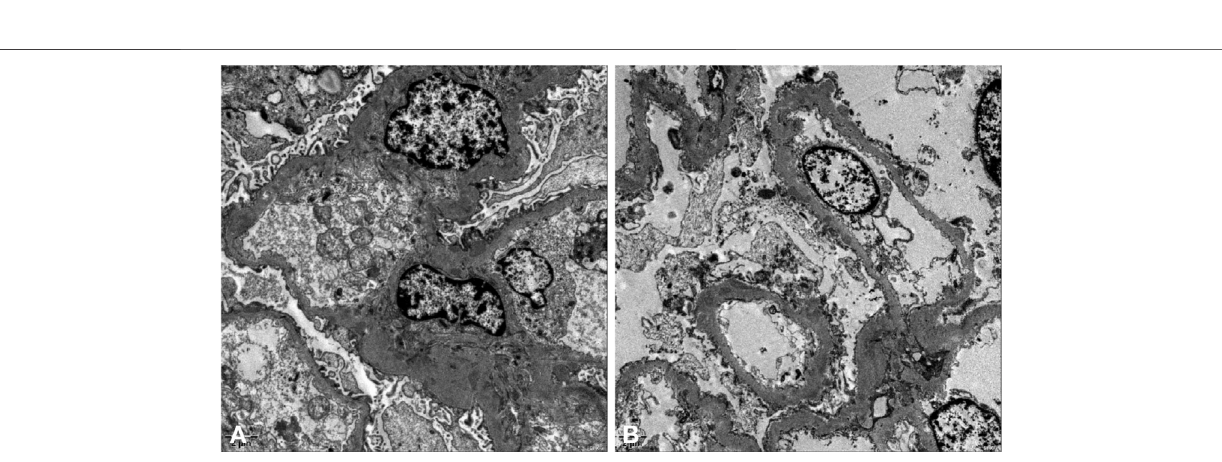
Frontiers in Pharmacology |